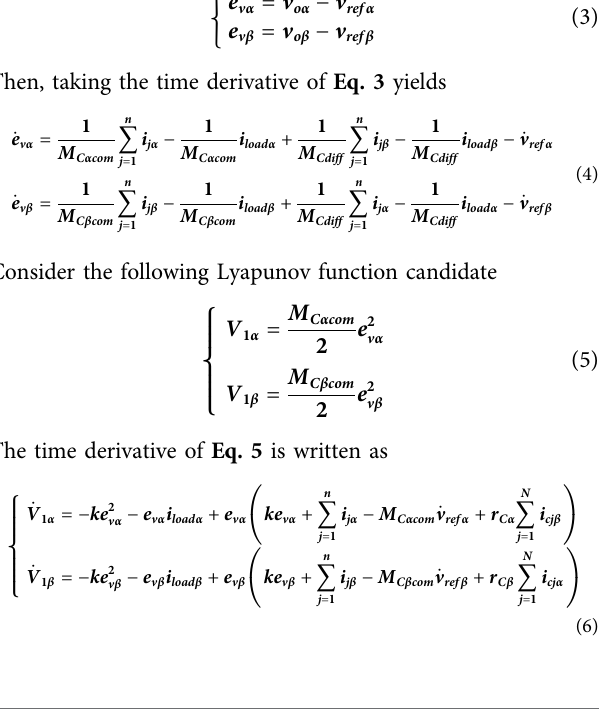
Frontiers in Energy Research |